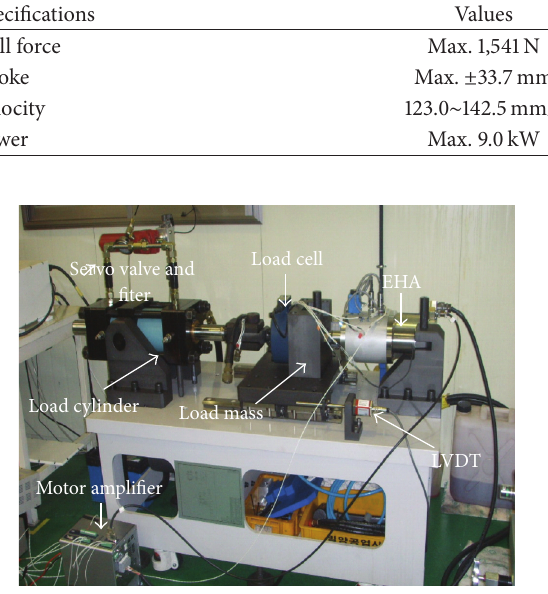
Figure 1: Photo of the position control test rig of the